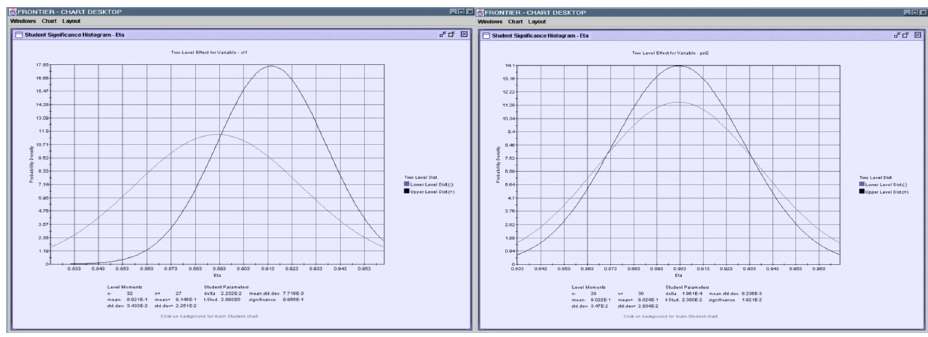
Figure 4: Comparison of populations characterized by individuals with high and low significances.